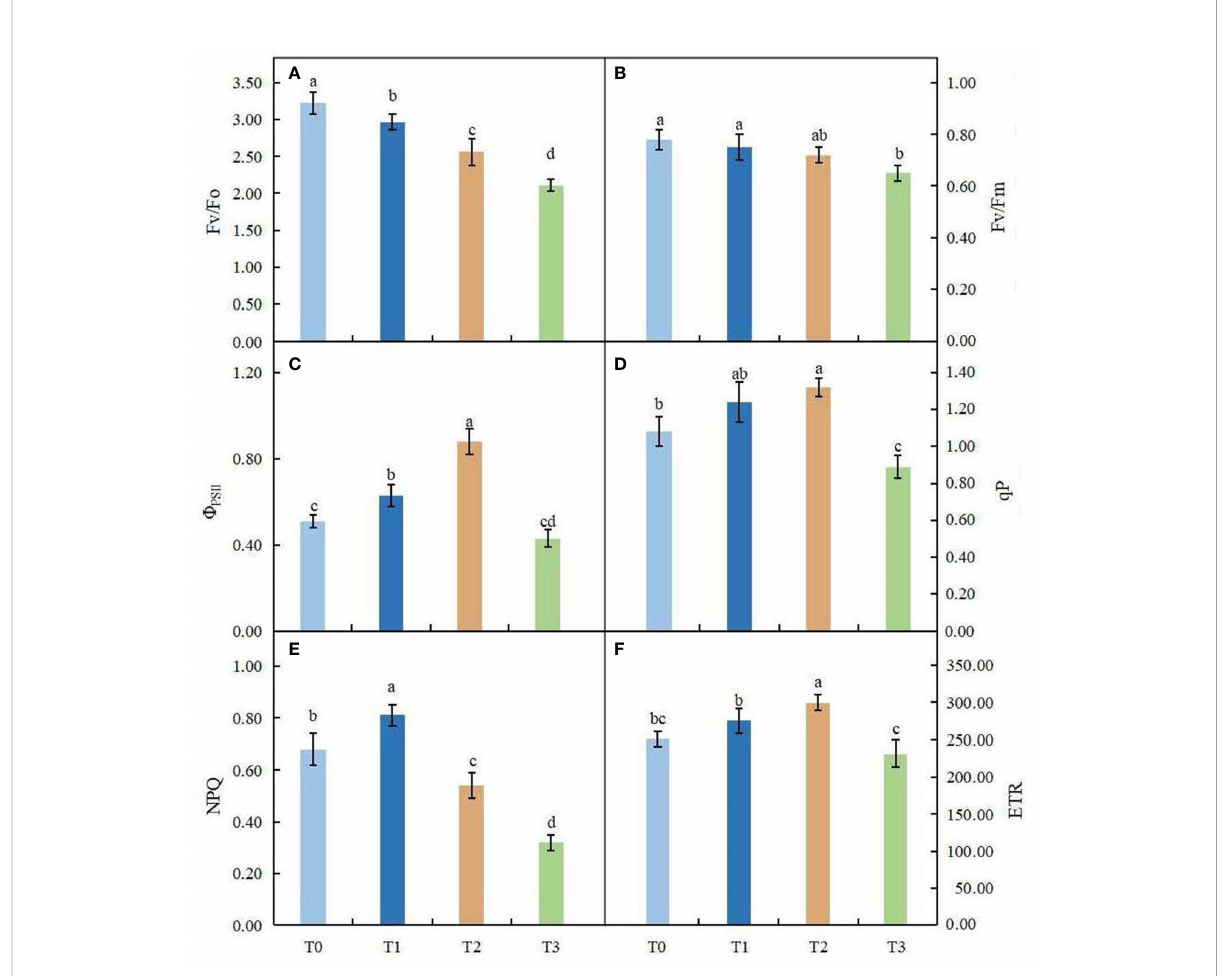
FIGURE 4 Effects of various light intensity on chlorophyll fl uorescence parameters in C. betulus after 60 days. Fv/Fo, potential activity of PSII (A) ; Fv/Fm , maximum quantum yield of photosystem II (B) ; F PSII , photochemical quantum ef fi ciency (C) ; qP, photochemical quenching parameter (D) ; NPQ, nonphotochemical quenching parameter (E) ; ETR, electron transfer rate (F) . Different lowercase letters indicate signi fi cant differences between treatments ( P < 0.05), n = 3.